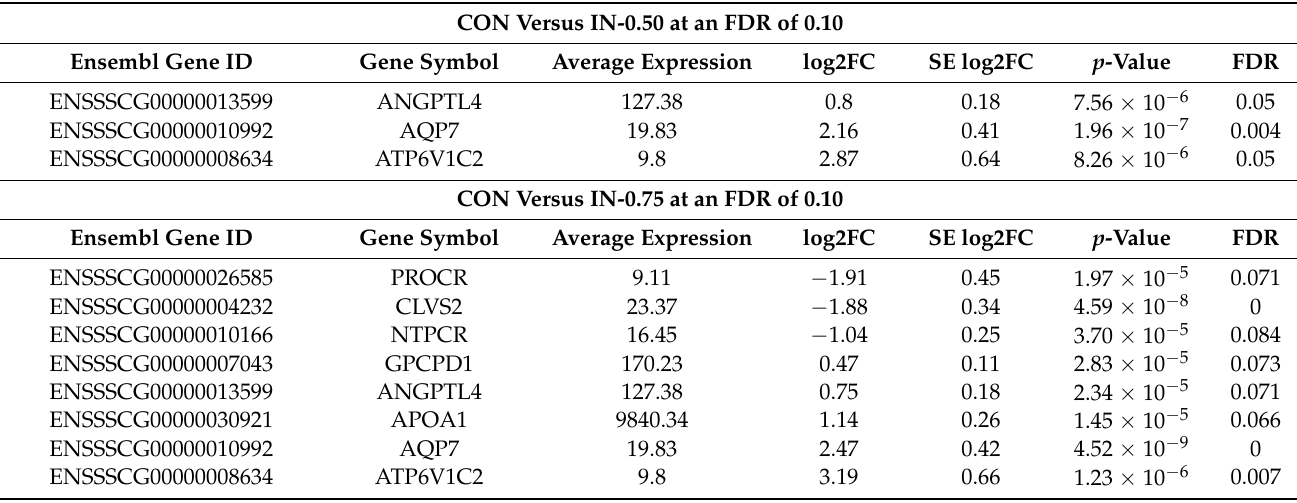
Table 2. Differentially expressed genes in the comparisons between the CON group and the IN-0.5 group or the CON group and the IN-0.75 group at a Benjamini–Hochberg false discovery rate (FDR) of 0.10. log2FC is log2 fold change, SE log2FC is the standard error of the log2FC. n = 7 for CON, n = 8 for IN-0.5, and n = 8 for IN-0.75. CON Versus IN-0.50 at an FDR of 0.10